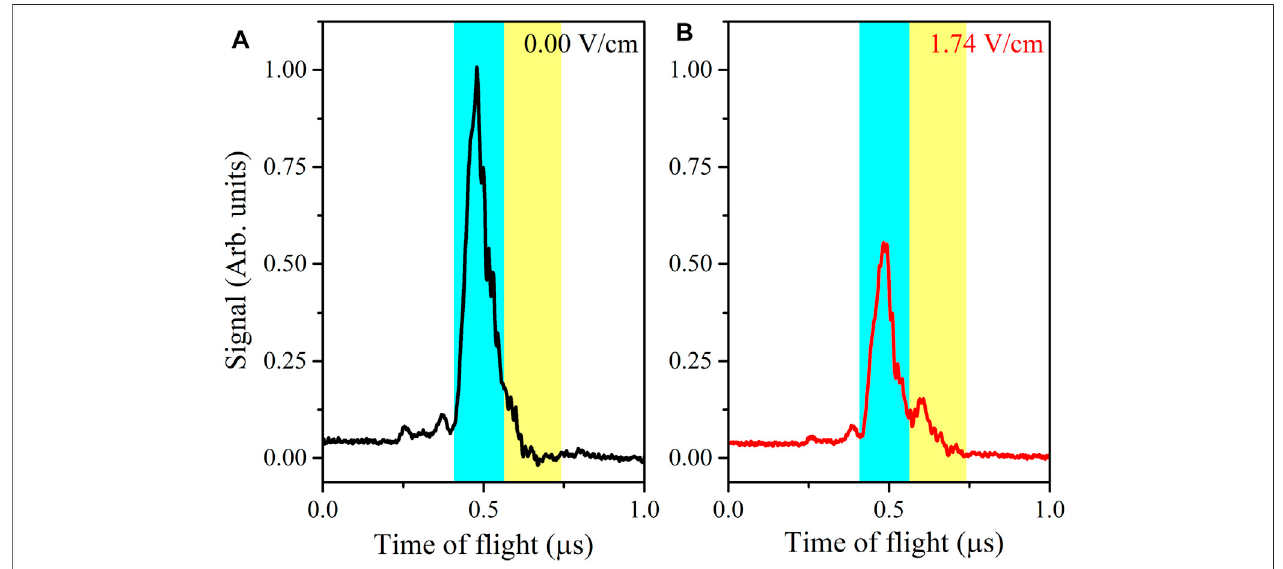
FIGURE 3 | (color online). Time of fl ight spectrum of the |38P 3/2 〉 state with a DC fi eld of 0 V/cm (A) and 1.74 V/cm (B) . The blue and yellow shadows mark the positions of the |38P 3/2 〉 and |38S 1/2 〉 states, respectively. The initial |38P 3/2 〉 atoms transfer to |38S 1/2 〉 due to the Förster resonant dipole interaction within the electric fi eld of 1.74